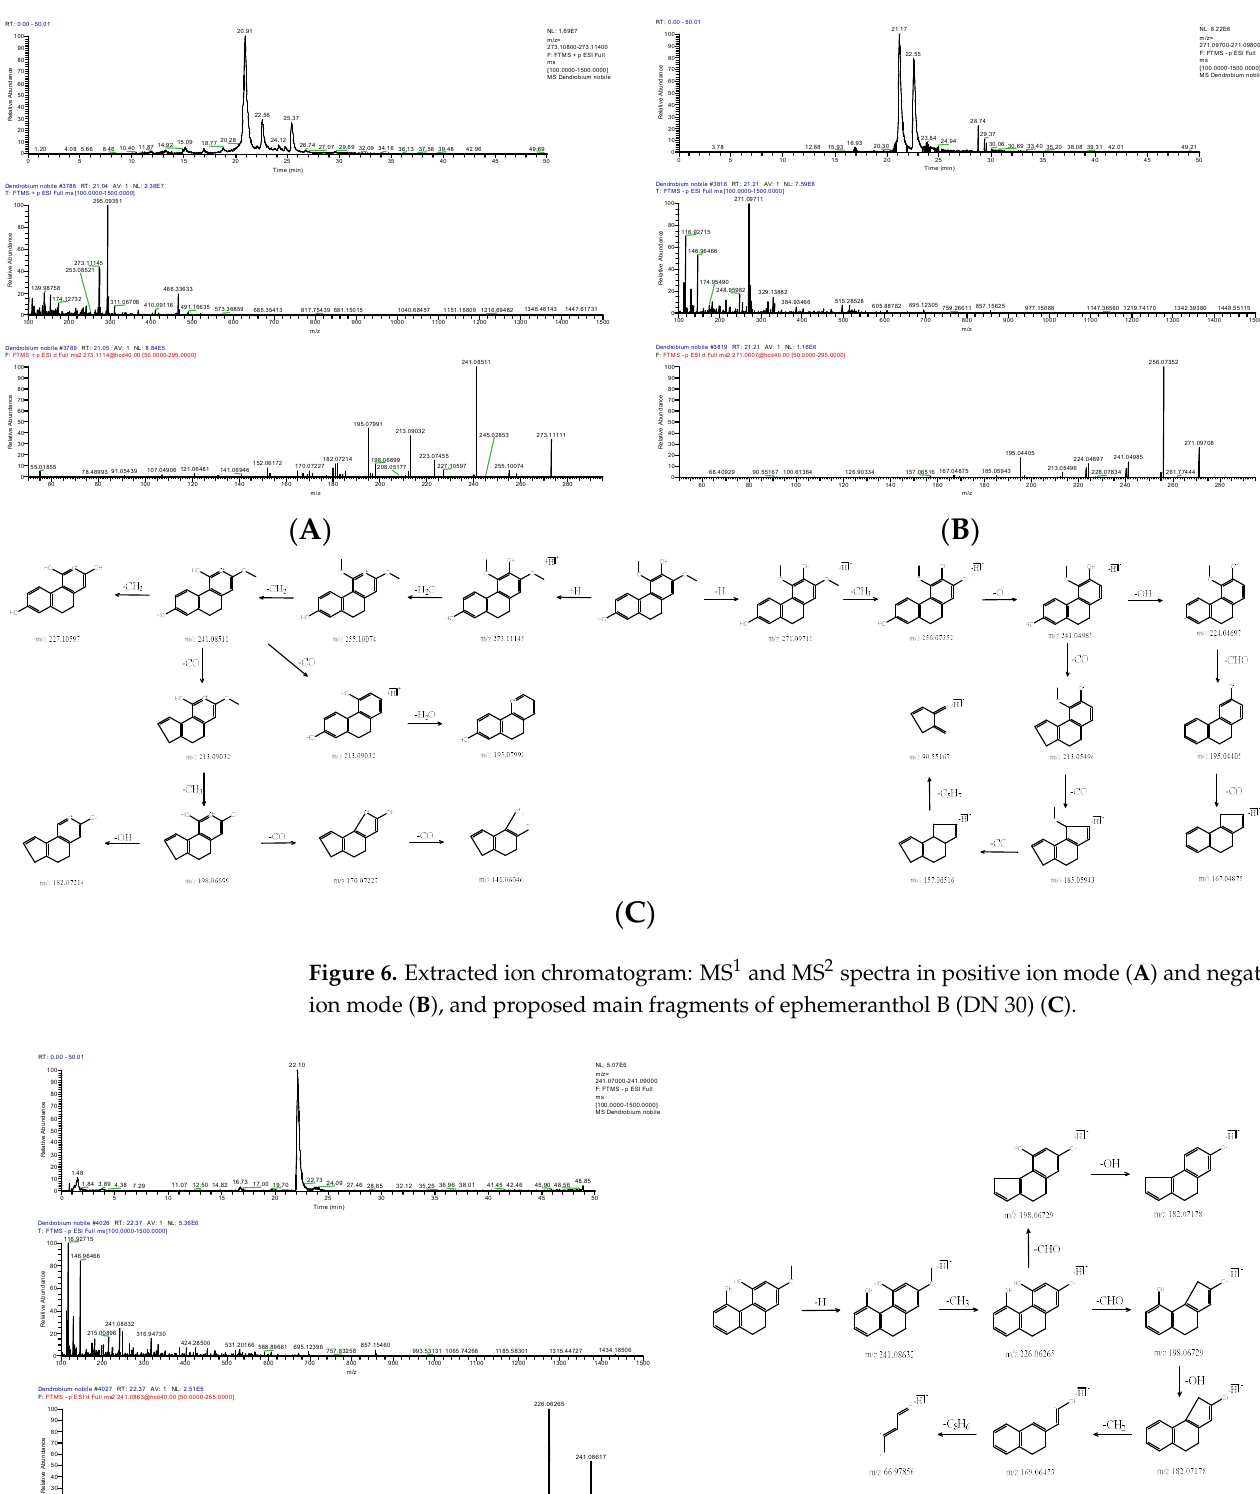
Figure 7. Extracted ion chromatogram: MS 1 and MS 2 spectra in negative ion mode ( A ), and proposed main fragments of 2-methoxy-9,10-dihydrophenanthrene-4,5-diol (DN 32) ( B ).